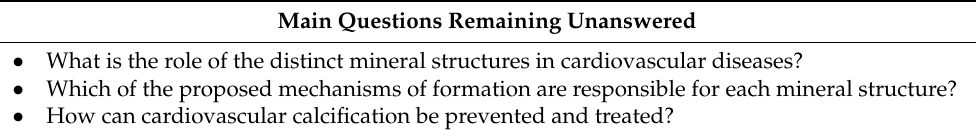
Table 2. List of main questions that remain unanswered in relation to cardiovascular calcification.